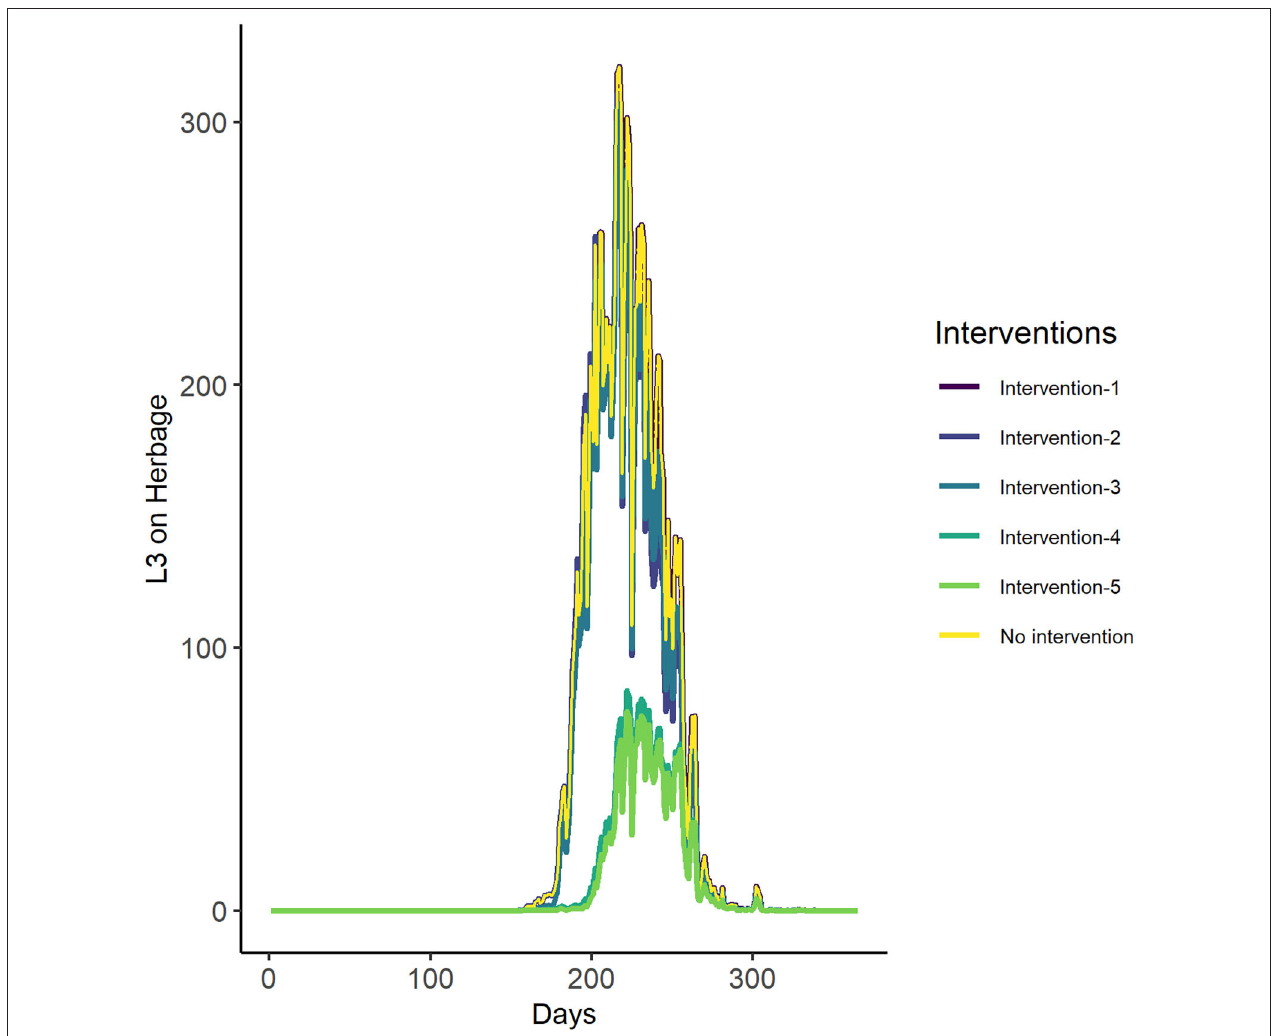
FIGURE 8 | The GLOWORM-FL output for all interventions (as stated in Tables 3 , 6 ) and no intervention, for the year 2018.